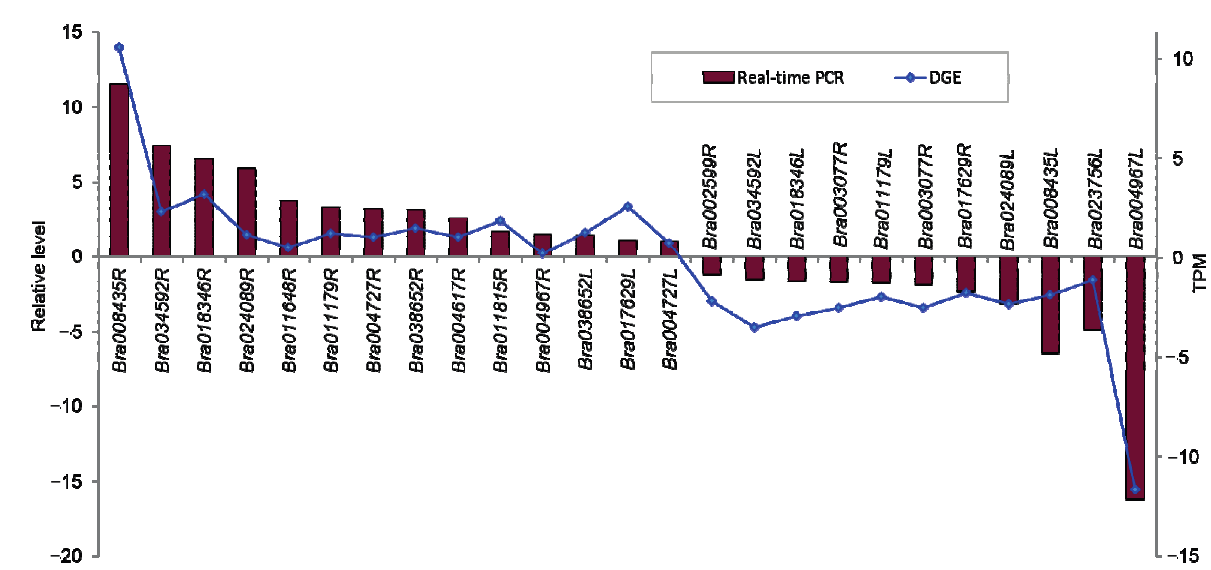
Figure 7. Real-time PCR validations of tag-mapped genes in root (R) and leaf (L). Relative level, (2 −Δ C t· Δ C t ); TPM, log2 Ratio